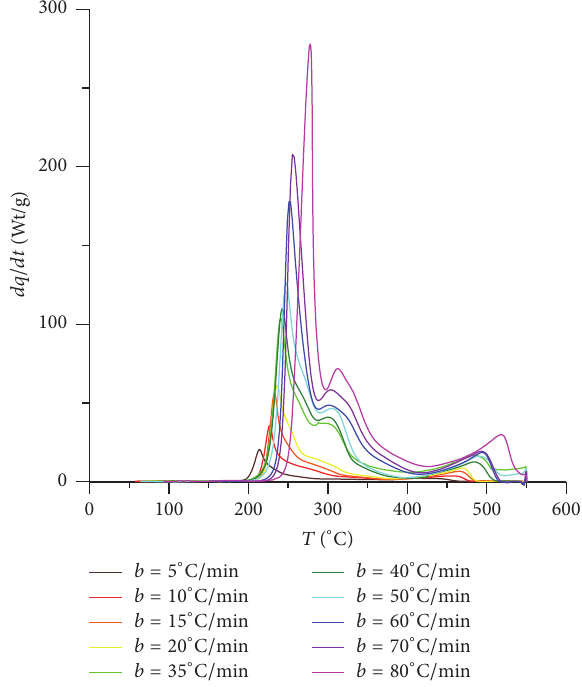
Figure 4: Kinetic curves of oil paraffins oxidation in DSC at a pressure of 5 MPa and different heating rates 𝑏